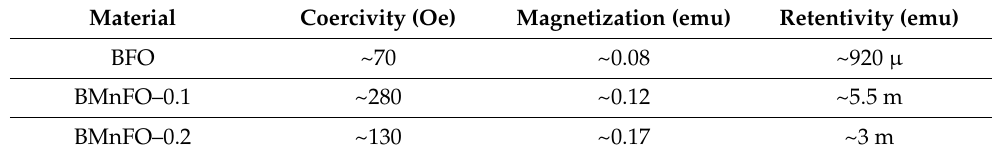
Table 1. Comparison table of magnetic parameters of pure and doped by Mn BFO material.